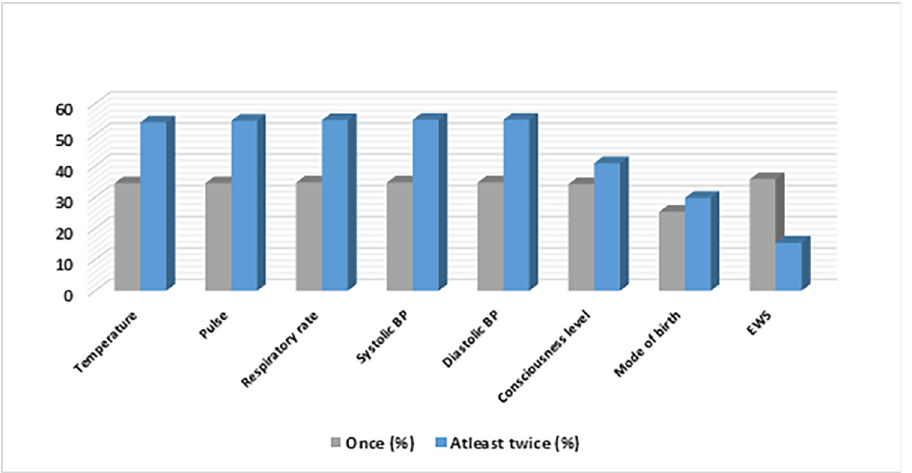
Fig 2. Completion rate of the EWS parameters and trigger